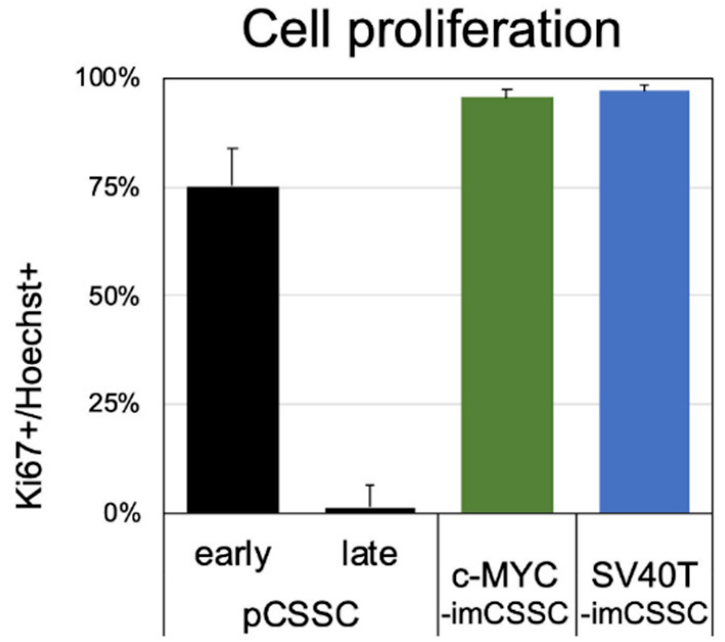
Figure 2. Cell proliferation of pCSSC and imCSSC cells. Immunostaining for the proliferation marker, Ki67, allowed quantification by computing the percentage of Ki67 positive cells against the number of nuclei (Hoechst staining). Passages 2–4 were used for pCSSC analysis at early passages; passage 7 was analyzed for pCSSC as late passages. Passages 10 to 14 were analyzed for the imCSSC. Results are expressed as mean ± SD. CSSC: corneal stromal stem cell; pCSSC: primary CSSC; imCSSC: immortalized CSSC; SD: standard